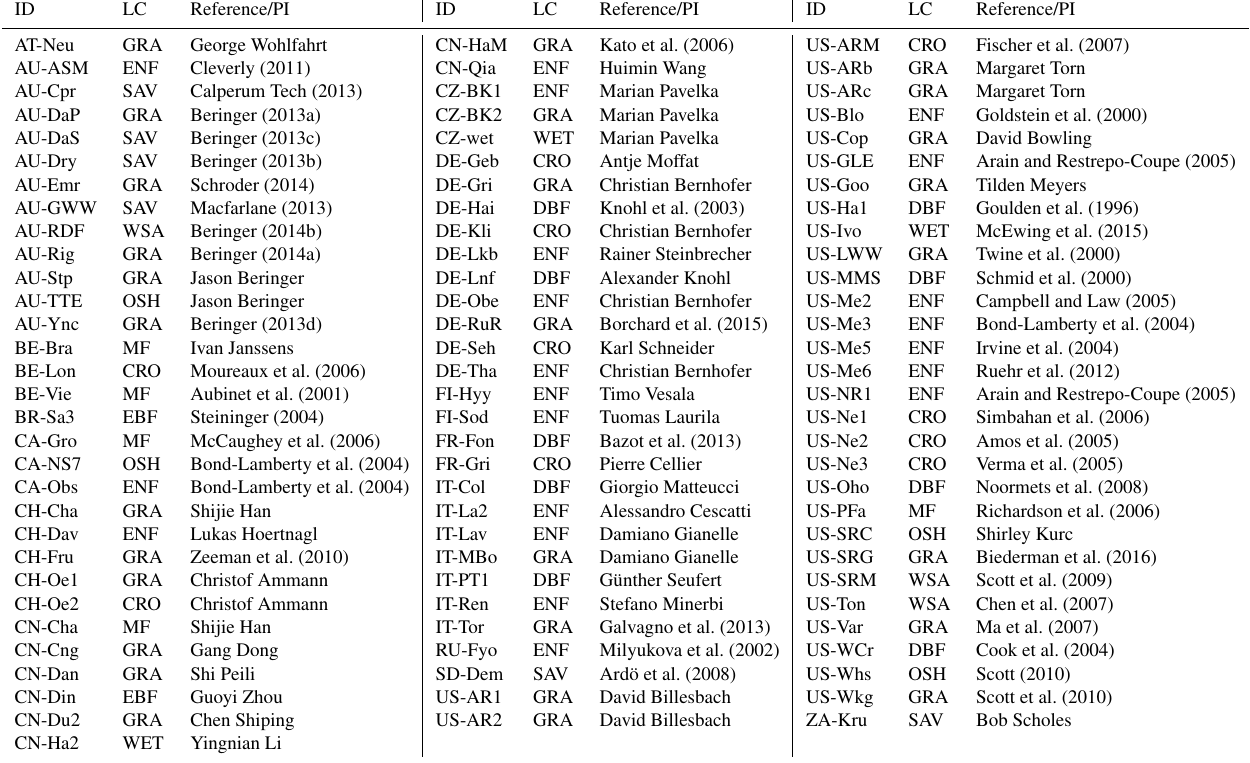
Table A1. List of the FLUXNET sites used in this study together with their FLUXNET code (ID), IGBP land cover (LC), and official reference (or principal investigator